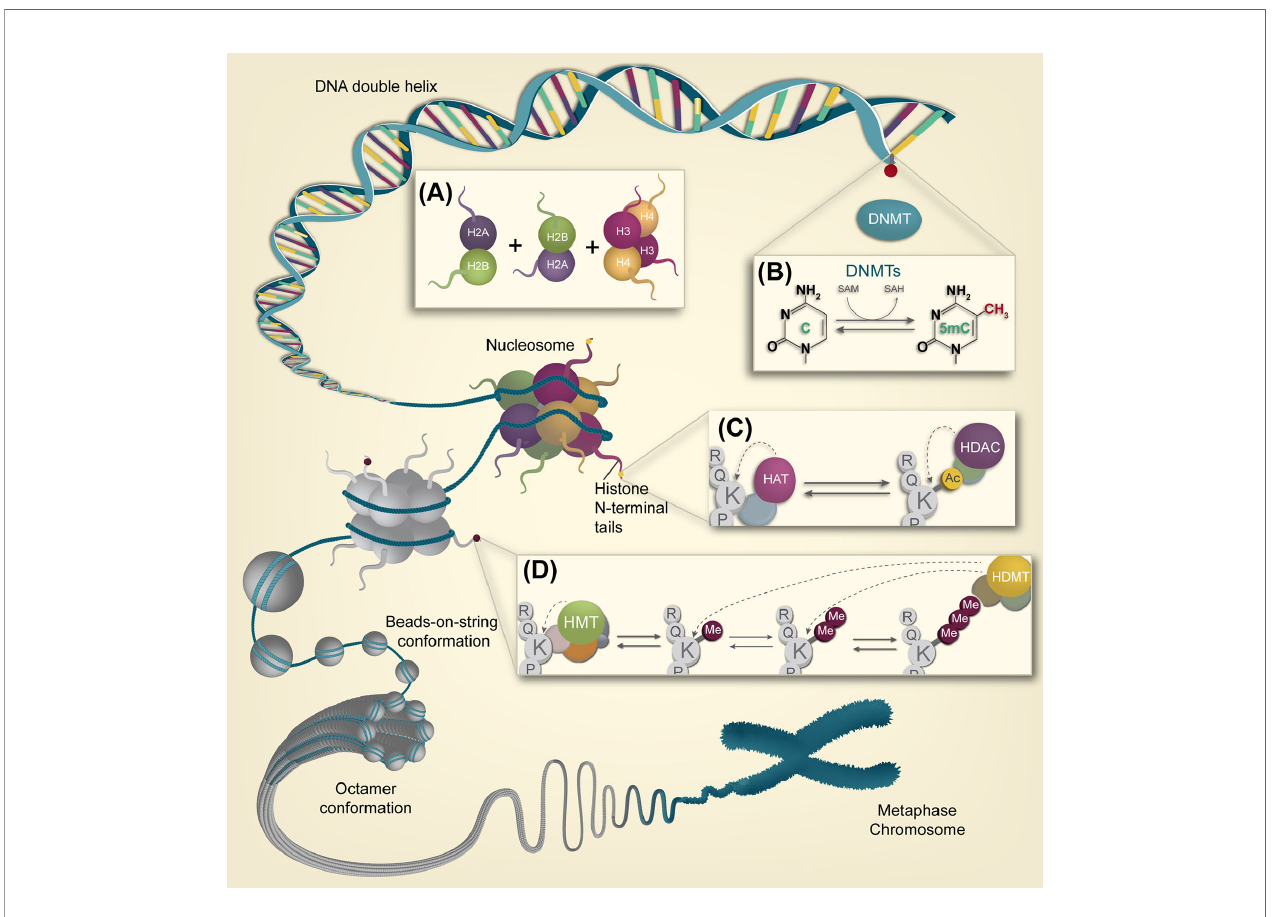
FIGURE 1 | Overview of the epigenetic landscape. Different compaction levels of chromatin are depicted, from naked DNA to the metaphasic chromosome. (A) Two dimers of H2A-H2B and a tetramer of H3-H4 histones are required for nucleosome assembly, the chromatin ’ s basic packaging unit (B) DNA methylation is a process carried out by DMNTs in CpG dinucleotides, particularly on CpG islands. This dynamic epigenetic mark can be reversed by enzymatic conversion. (C) Histone acetylation is performed on lysine residues by HAT enzyme complexes. In contrast, histone lysine deacetylation is carried out by HDACs enzyme complexes. (D) Histone lysine methylation is carried out by HMT complexes. Lysines can be processively methylated from mono to di and